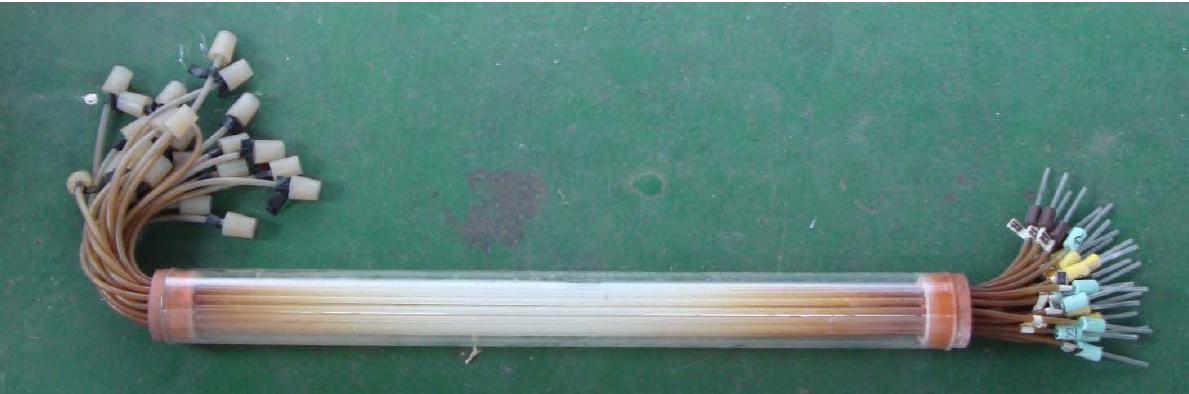
Figure 6. Multiple air-cooled condenser used to collect water (including tritium) after heating peat/clay in an oil bath at 130 °C in tubes attached by the silicone rubber bungs to the left. In use the condenser sloped downwards (left to right) to the collecting test tubes, shielded by the plastic caps at the